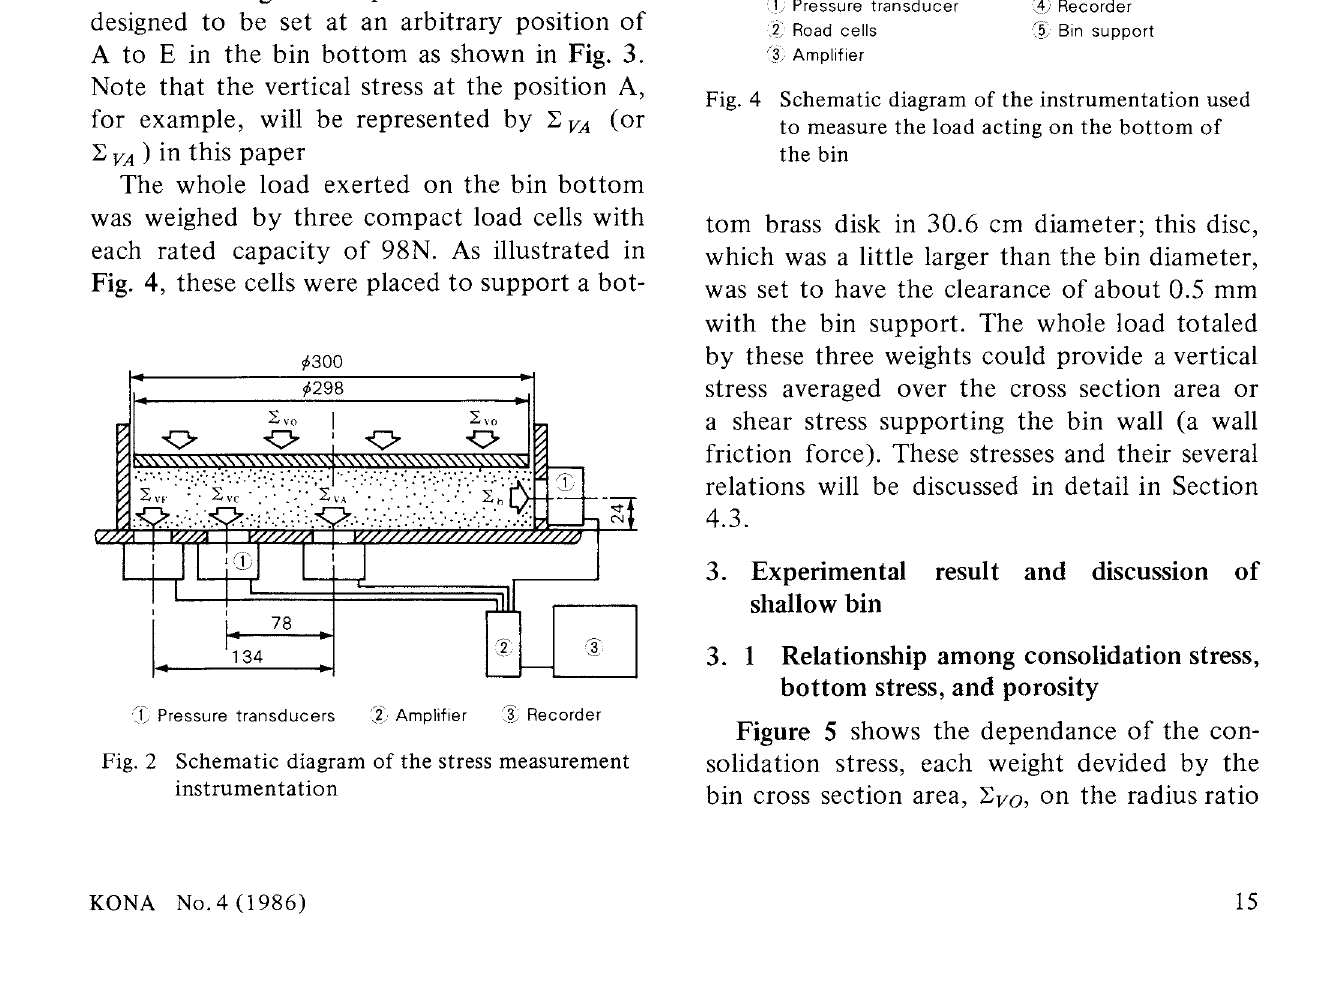
Fig. 2 Schematic diagram of the stress measurement instrumentation